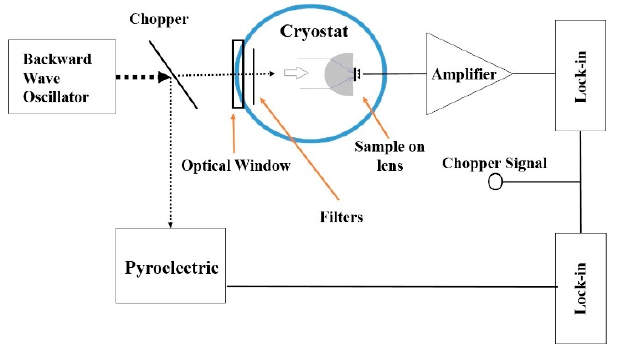
Figure 8. A diagram of the experimental arrangement.